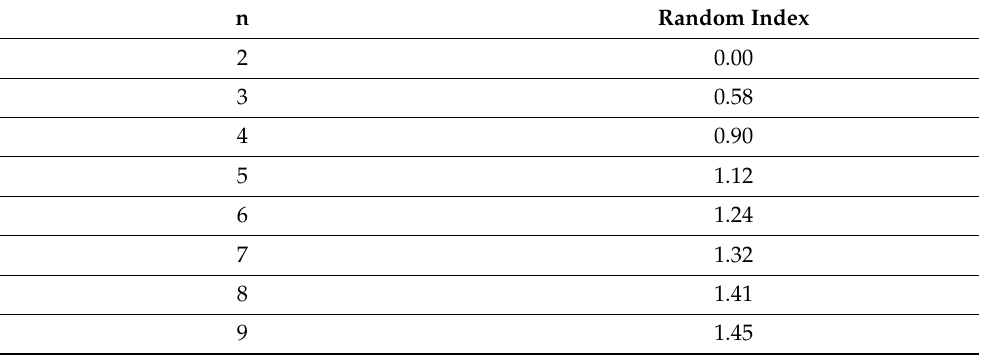
Table 3. The random index ( RI ) value by [27].